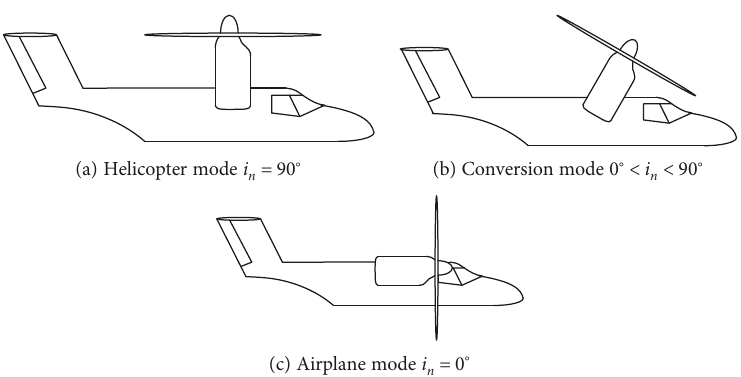
Figure 1: Tilt-rotor aircraft three fl ight